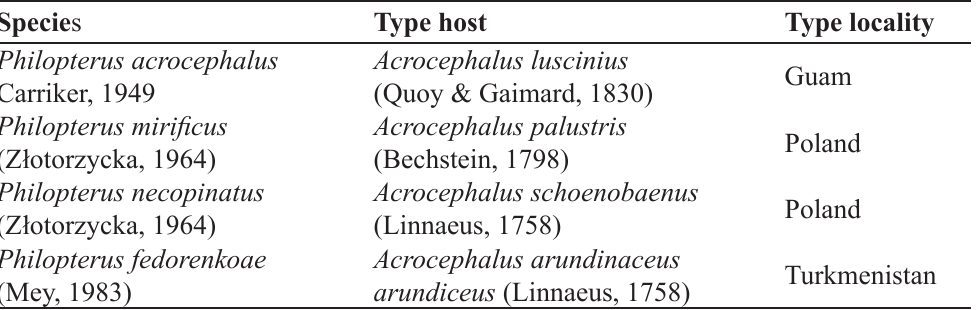
Table 1. To date described species of Philopterus complex from the family